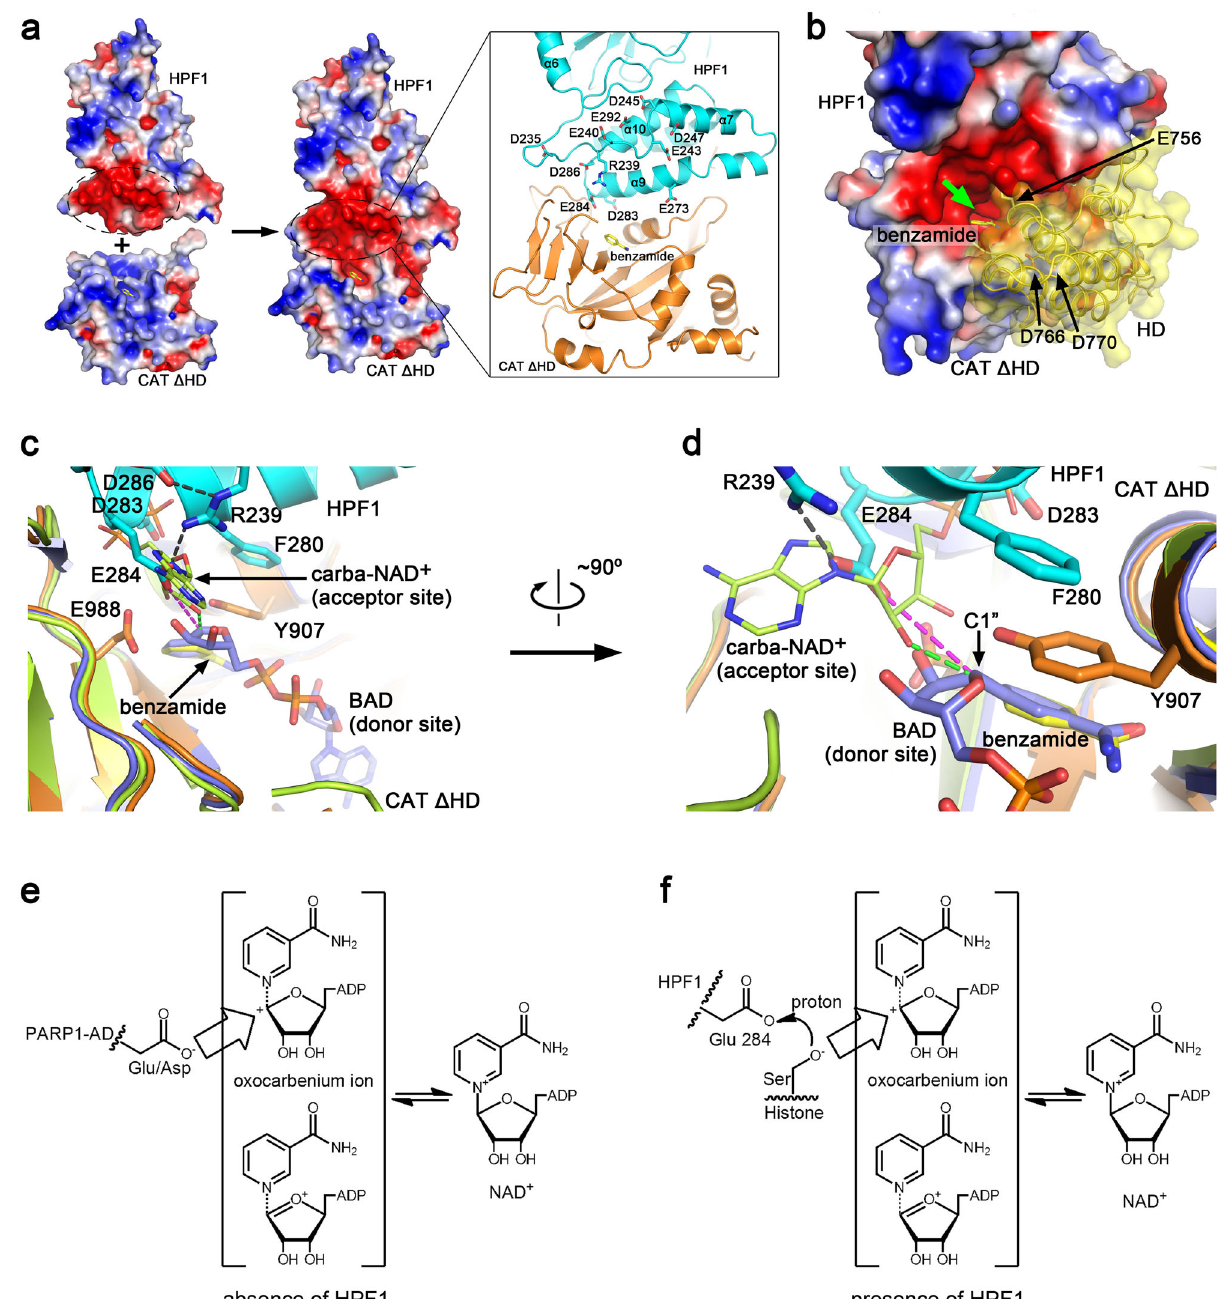
Fig. 3 Structural basis of the mechanism through which HPF1 modulates PAPR1 activity. a Surface electrostatic potential of human HPF1, PAPR1-CAT Δ HD and the hetero-dimer. The negatively and positively charged regions are colored red and blue, respectively. A strongly negatively charged region in HPF1 merges with the active site of PARP1-ART in the complex, creating a joint negatively charged active site. The inset on the right shows the acidic and basic residues in this negatively charged region of HPF1. b A close view of the remodeled active site and the HD domain if in the folded state. The HD domain is shown as cartoons covered by transparent surface based on a superimposition of the ART domain from the HPF1/PAPR1-CAT Δ HD structure and the ART domain from the DNA-bound PARP1 crystal structure (PDB 4DQY). The green arrow indicates the entrance to the tunnel leading to the remodeled active center. c , d Superimposition of our HPF1/PAPR1-CAT Δ HD complex structure (cyan and orange) with the previously reported PARP1- ART/BAD complex structure (PDB 6BHV, light-blue) 22 and the PARP1-CAT/carba-NAD + complex structure (PDB 1A26, lime) 29 . Two different views of the active cite are shown. BAD (light-blue sticks) is an NAD + analog that mimics the ADP-ribosylation donor. The ADP moiety of carba-NAD + , shown as lime sticks in this fi gure, has been proposed to represent the ADP-ribosylation acceptor for ADPr chain elongation/branching. e A proposed catalytic mechanism of PARP1 automodi fi cation in the absence of HPF1. Without HPF1, the acidic residues in automodi fi cation domain (AD) of PARP1 can access the active center to get ADP-ribosylated. f Proposed catalytic mechanism of histone serine ADP-ribosylation in the presence of HPF1. Upon HPF1 binding, HPF1 Glu284 carboxyl is positioned approximately 4.6 Å (see the purple dashed lines in c and d ) away from the donor NAD + ribose (represented by BAD). This distance is too great for Glu284 itself to accept the ADP-ribose, but could catalyze ADP-ribosylation of a serine by promoting deprotonation of its sidechain